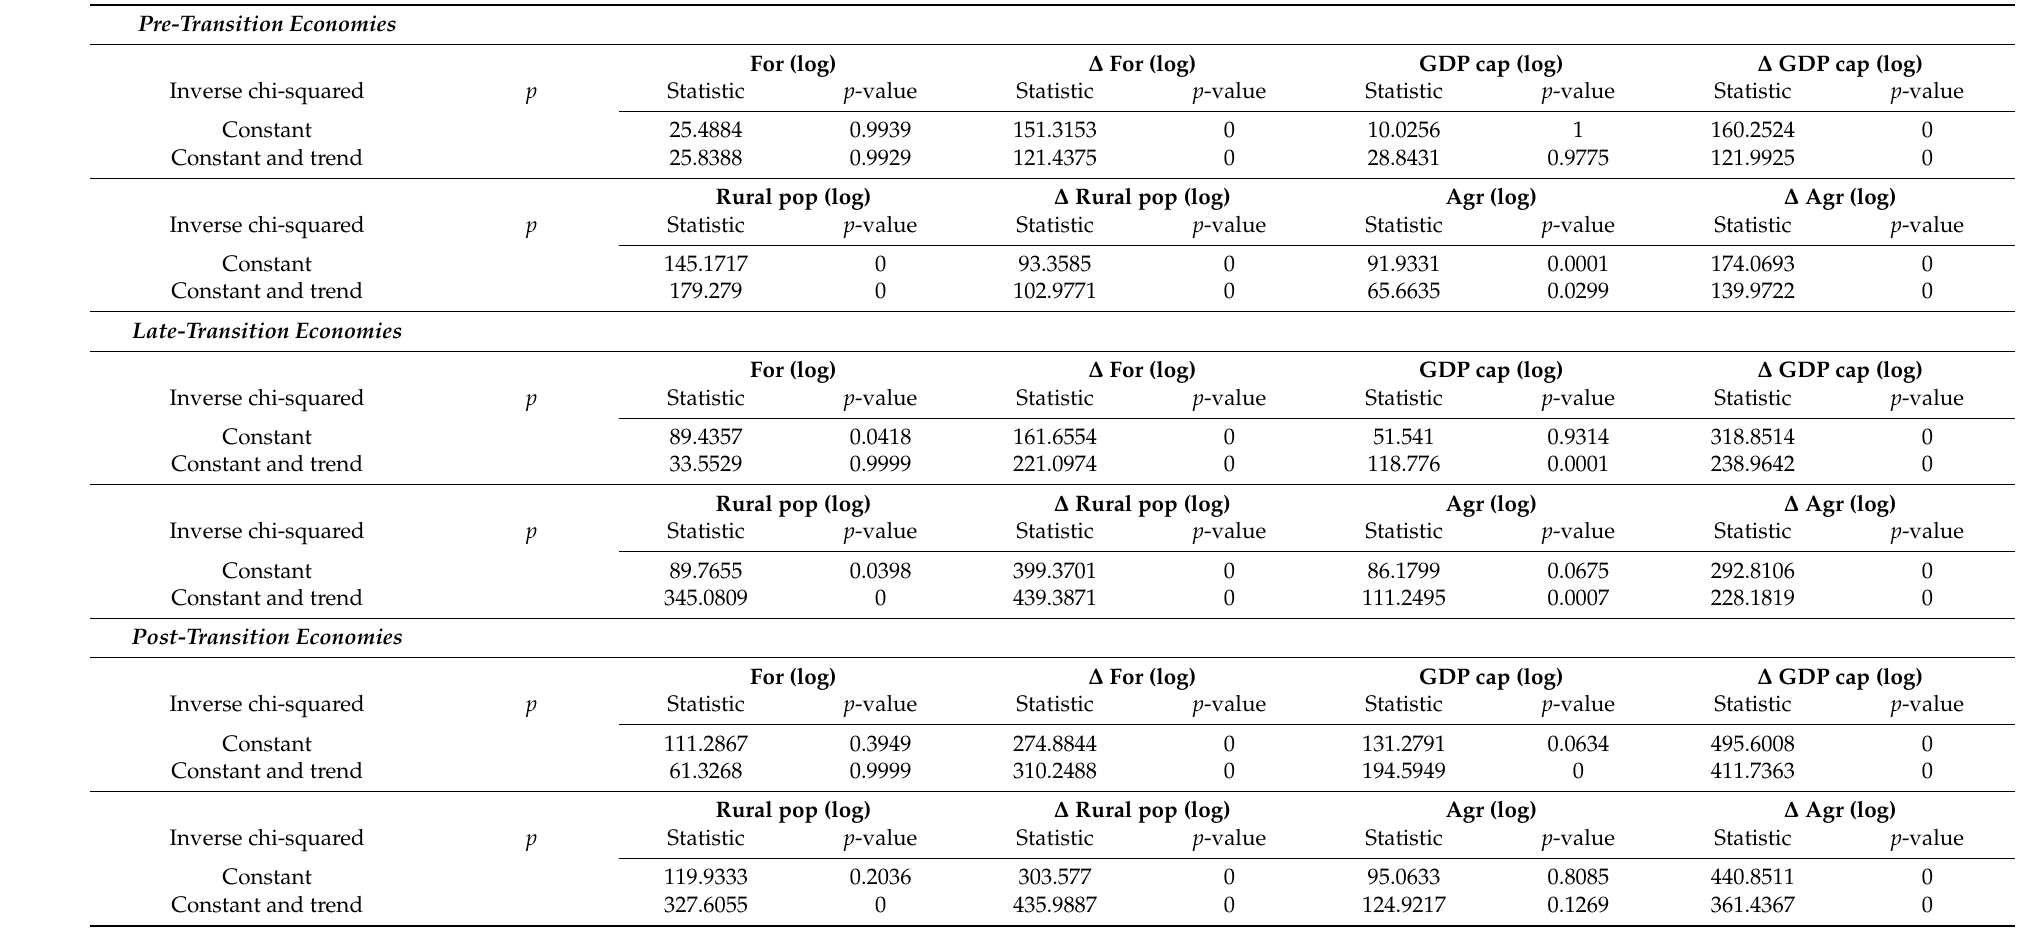
Table A13. Unit rot tests, forest